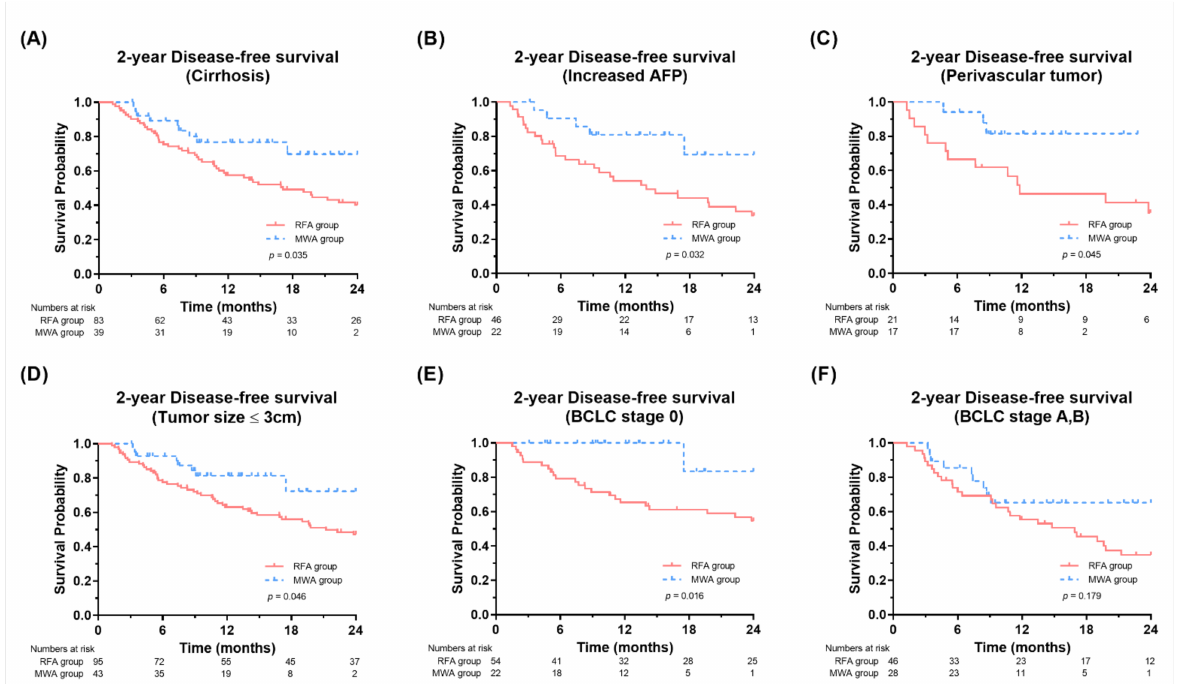
Figure 3. Comparison of disease-free survival in the MWA and RFA groups in subgroups with ( A ) cirrhosis, ( B ) increased AFP, ( C ) perivascular tumor, ( D ) small tumor size ( ≤ 3 cm), and ( E , F ) BCLC stage 0, A and B. RFA, radiofrequency ablation; MWA, microwave ablation; AFP, alpha-fetoprotein; BCLC, Barcelona Clinic